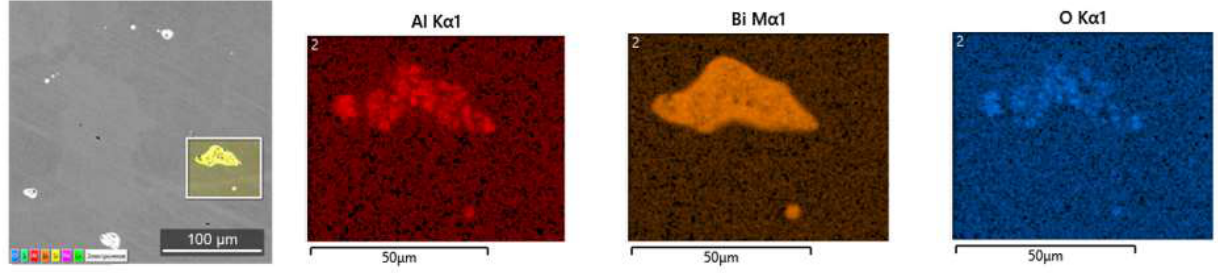
Figure 8. Al 2 O 3 -Bi complex inclusion and concentration maps of aluminum, bismuth, and oxygen in steel 0.4C-Cr.